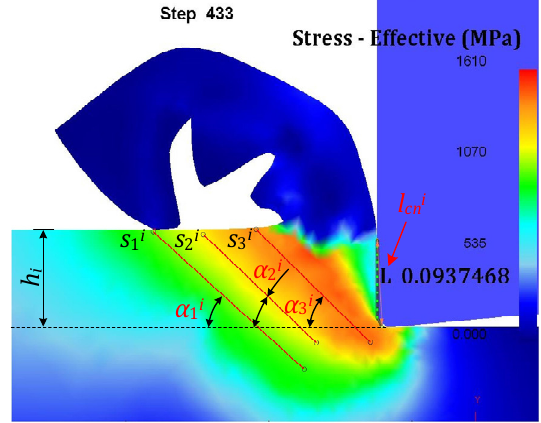
Figure 3. Evaluation of the shear angle and contact length based on the stress diagram.